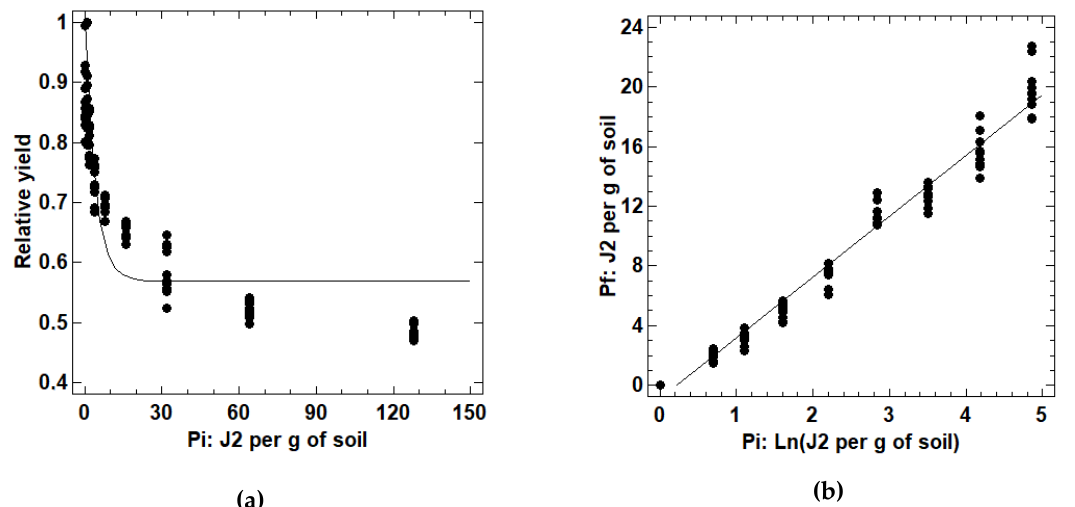
Figure 1. The relative yield of strawberry ‘Fortuna’ ( a ) and final densities of Meloidogyne hapla ( b ) per g of soil 90 days after nematode inoculation in pots in a growth chamber, plotted against progressively higher initial populations ( Pi ). Data from two repeated experiments are included (five replicates per experiment × two experiments).